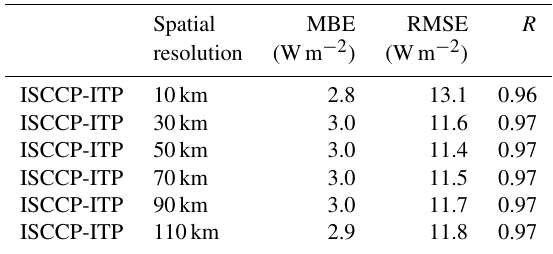
Table 4. Effect of spatial resolution (from 10 to 110km) on accu- racy of our estimated daily PAR product (ISCCP-ITP) compared to observations at the 42 NEON